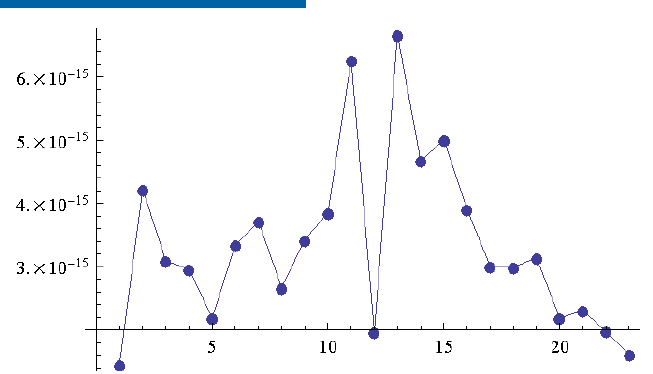
Figure 7. Second example: relative L